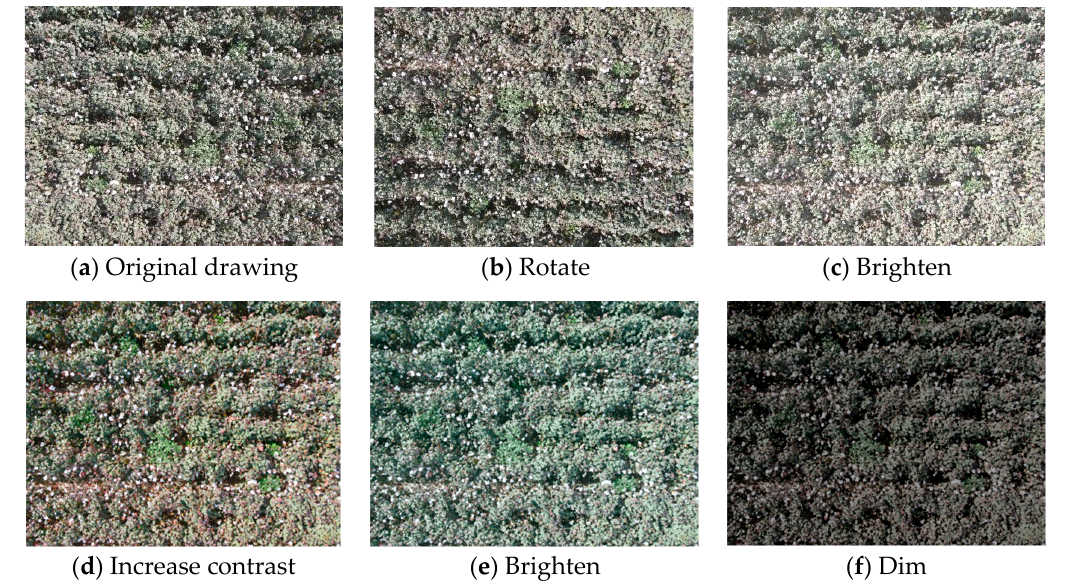
Figure 2. Original image and enhanced image.